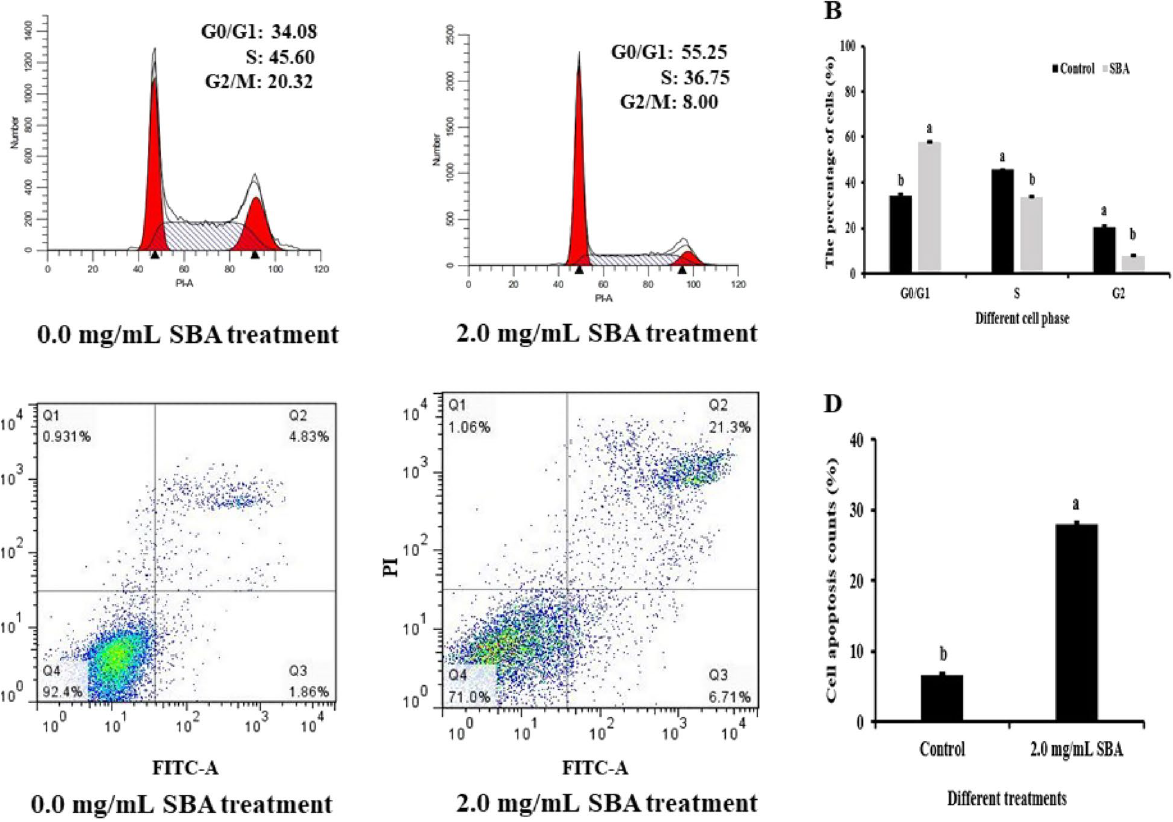
Figure 1. ( A – D ). Effects of SBA on cell cycle and cell apoptosis in IPEC-J2. IPEC-J2s were treated with 0.0 (control) and 2.0 mg/mL SBA for 24 h. The proportion of the cells in different cycle phases and cell apoptosis rates in different SBA treatments were analyzed using FCM. Cell cycle ( A ) and its analysis ( B ); and cell apoptosis rates ( C ) and its analysis ( D ). Data are presented as mean±SEM. Different lowercase letters are significantly different ( p < 0.05, Student’s t-